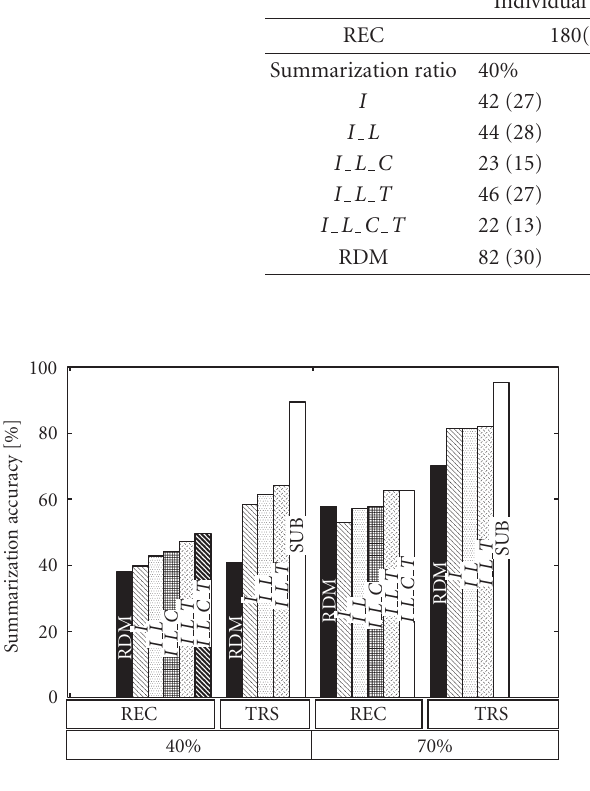
Figure 9: Individual utterance summarization at 40% and 70% summarization ratios. REC: summarization of recognition results, TRS: summarization of manual transcriptions, RDM: random word